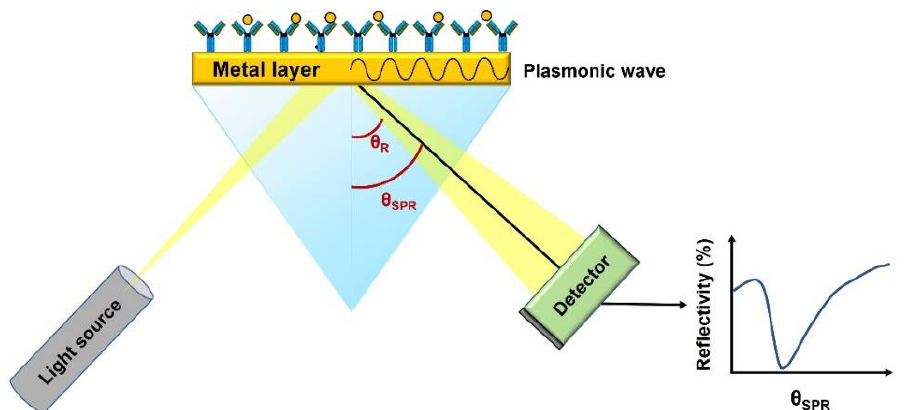
Figure 9. Sketch diagram of Surface plasmon resonance (SPR). Excitation of collective oscillations of electrons by the transverse magnetic polarized light at the metal interface.